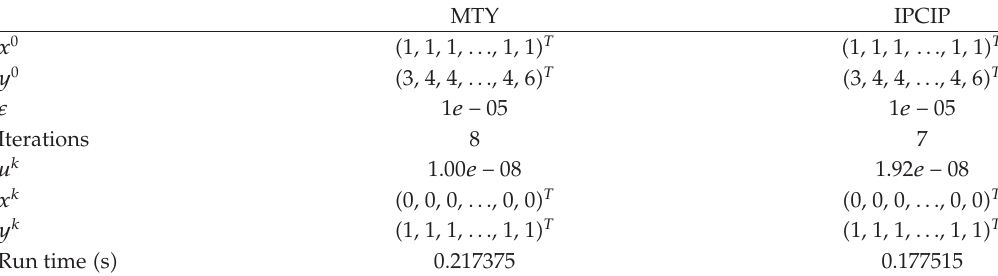
Table 3: Computational results of test problem